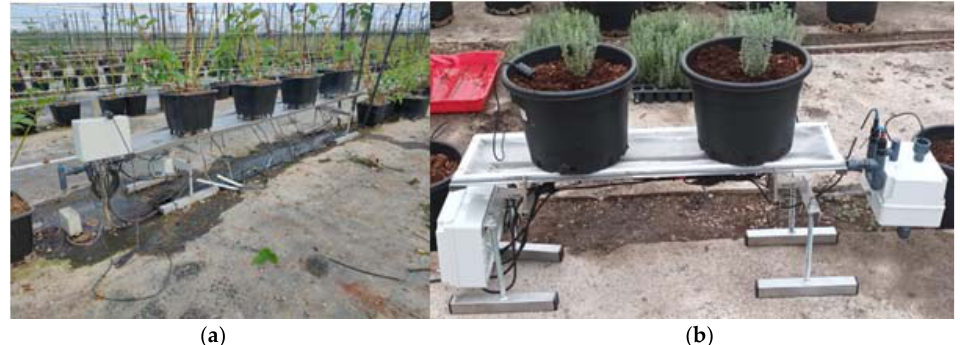
Figure 13. ( a ) Weighing tray with torsion load cells in a Mexican commercial fruit facility. ( b ) Small weighing tray in a commercial facility in the South of Spain.